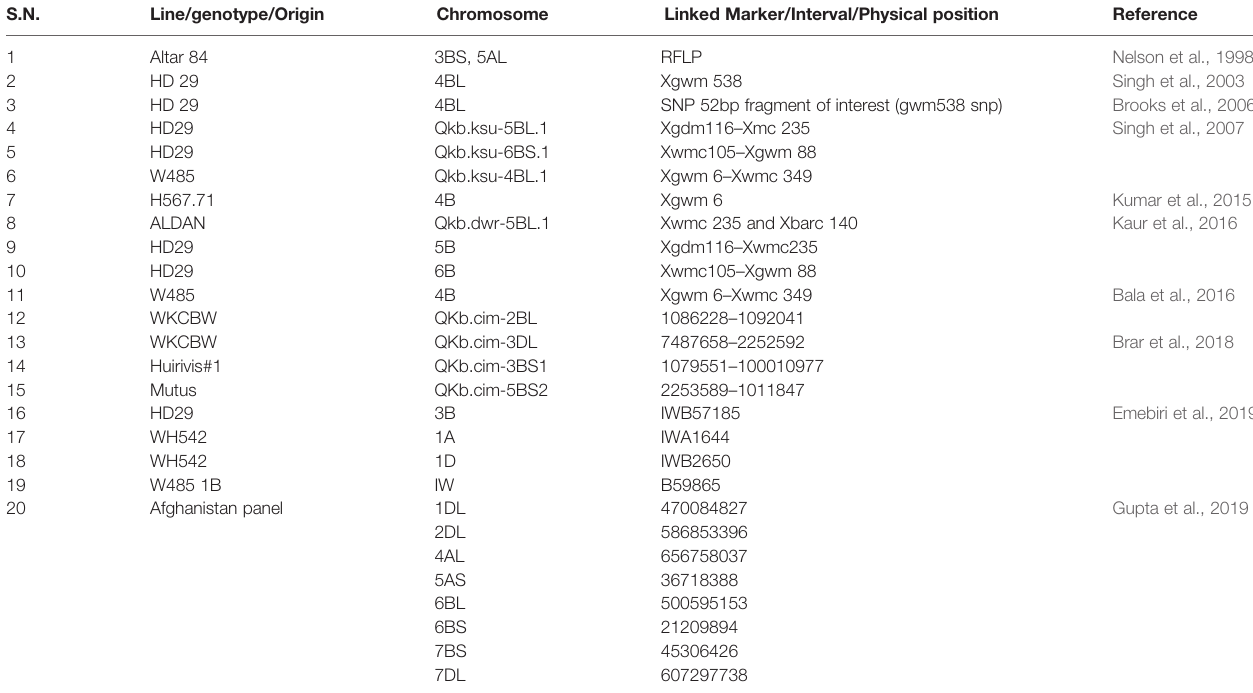
TABLE 1 | QTLs reported conditioning the KB resistance trait in wheat.